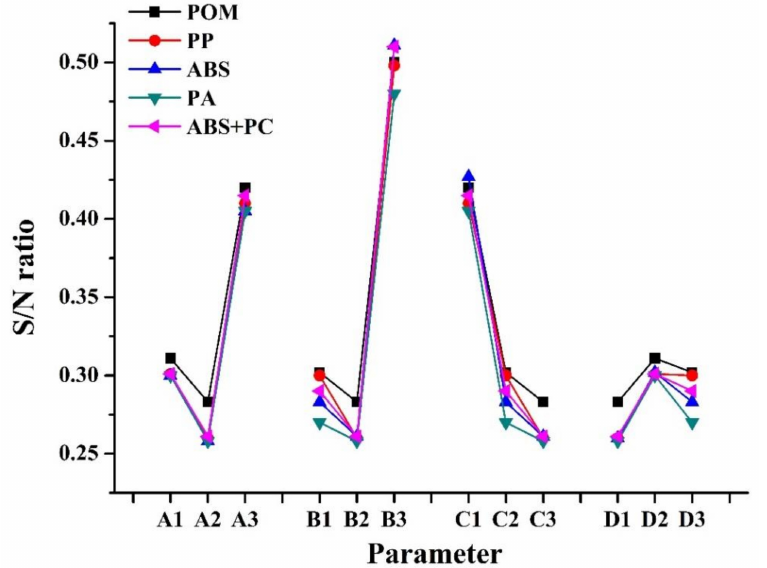
Figure 7. Variations in the signal-to-lose (S/N) ratio with factor level for warpage phenomenon of the micro-sized part by numerical simulation (POM/ABS/PP/PA/ABS +